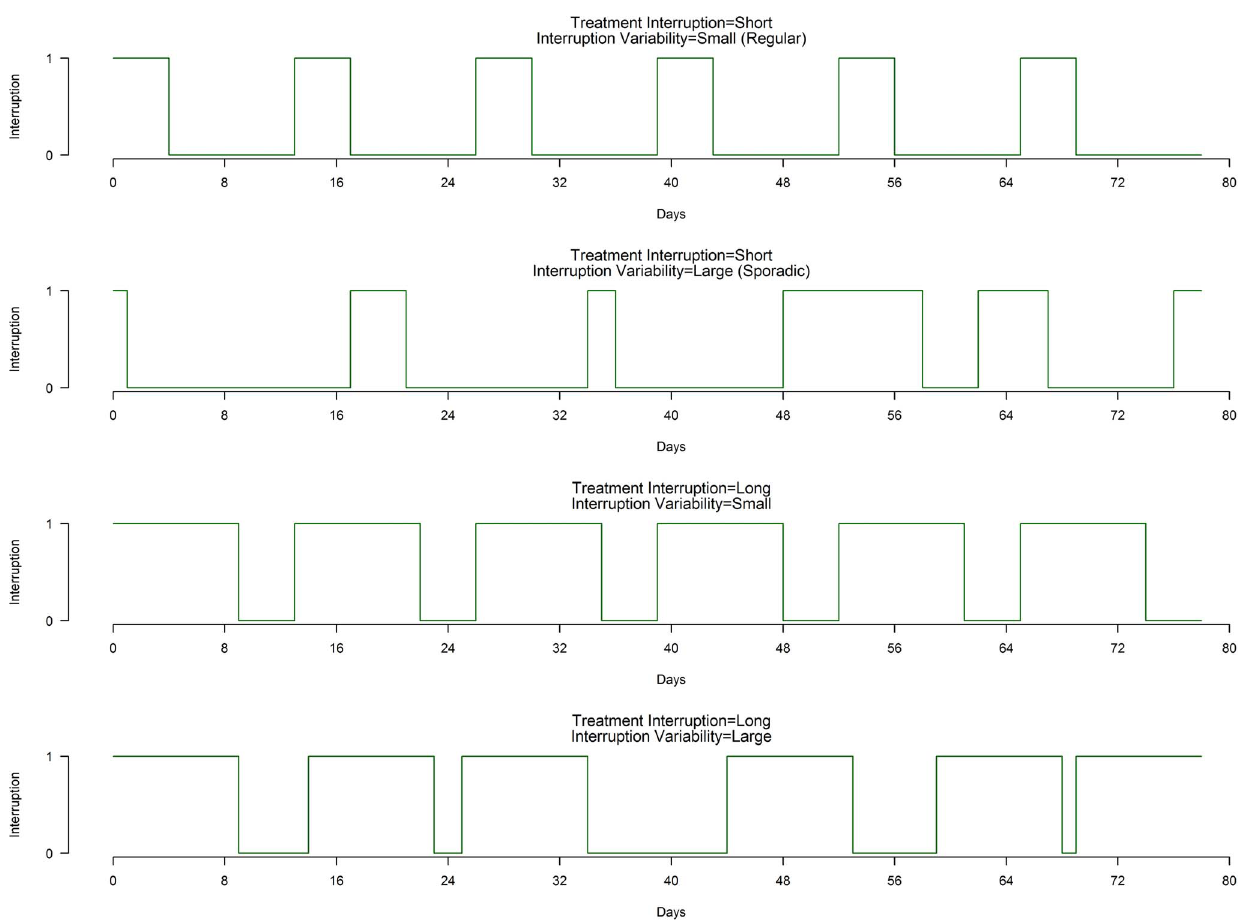
Figure 1. Illustration of 4 different treatment interruption categories, based on length of interruption in days (short or long), and variability of interruption (small/regular or long/sporadic). Y-axis indicates treatment interruption as 0 (no; on treatment) or 1 (yes; interruption/missed dose).